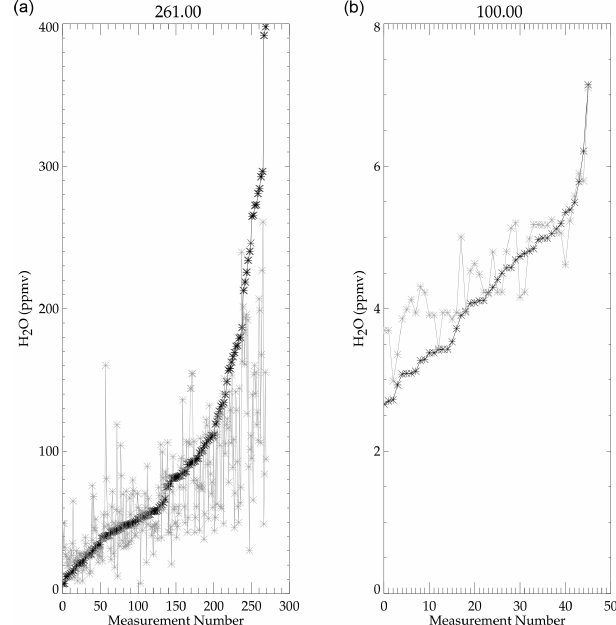
Figure 4. A comparison of coincident Boulder BFH and AIRS measurements (a) at 261hPa and MLS-Aura measurements (b) at 100hPa is shown. The BFH measurements are sorted by value, black, the satellite measurements in